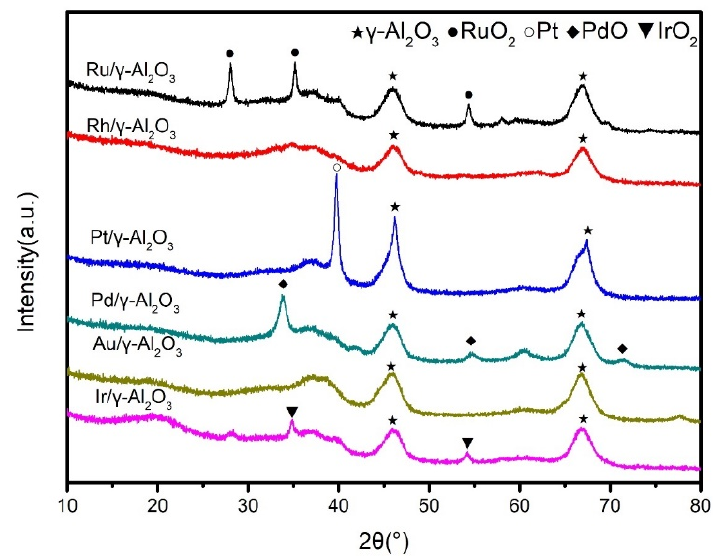
Figure 2. 1,2-DCE conversion curves of ( a ) Au/ γ -Al 2 O 3 , Ir/ γ -Al 2 O 3 , and Pd/ γ -Al 2 O 3 catalysts and ( b ) Pt/ γ -Al 2 O 3 , Rh/ γ -Al 2 O 3 , Ru/ γ -Al 2 O 3 catalysts.